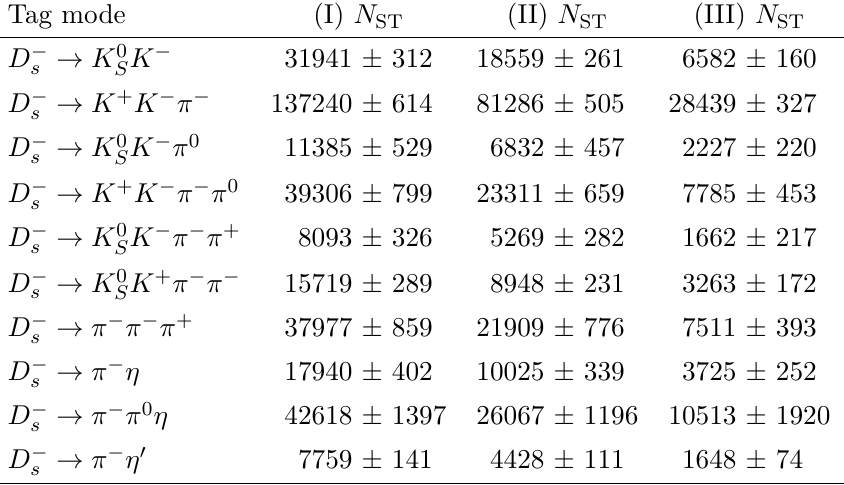
Table 9 . The ST yields for the samples collected at (III) 4.226 GeV. The uncertainties are